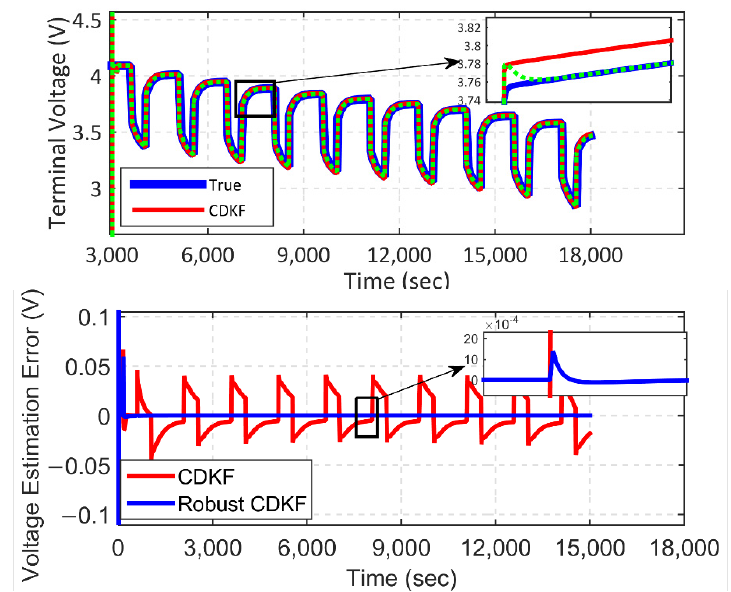
Figure 11. Terminal voltage estimation (aged battery).